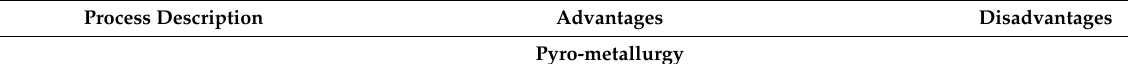
Table 2. Comparison of applied metallurgical processes